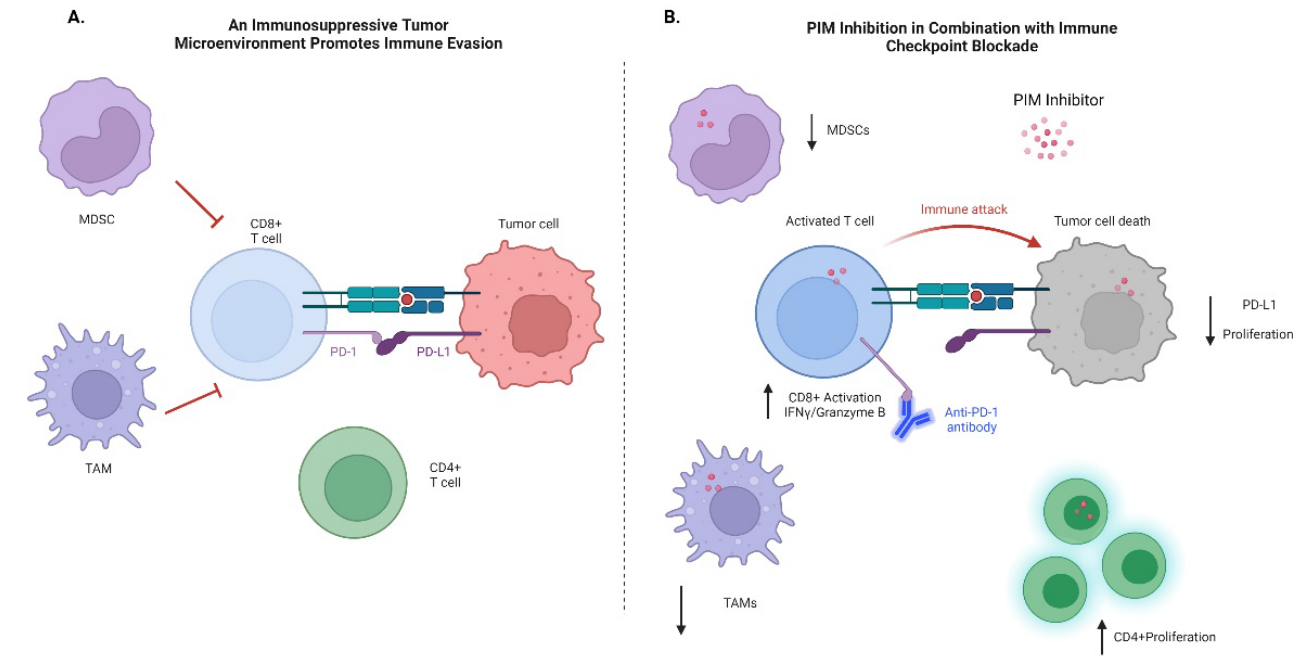
Figure 1. Targeting PIM kinases in combination with immune checkpoint therapy. ( A ) The tumor microenvironment contains immunosuppressive immune cells, including myeloid-derived sup- pressor cells (MDSCs) and tumor-associated macrophages (TAMs), that prevent anti-tumor responses. Tumor cells, MDSCs, and TAMs express programmed death ligand 1 (PD-L1), an immune checkpoint molecule that dampens cytotoxic CD8 + T-cell immune responses. ( B ) PIM inhibitors used in combination with immune checkpoint inhibitors decrease MDSCs and TAMs, increase CD4 + T cell proliferation, and increase CD8 + T cell activation, thereby promoting decreased tumor growth. Adapted from “Immune Checkpoint Inhibitor Against Tumor Cell”, by BioRender.com (2022). Re- trieved from https://app.biorender.com/biorender-templates (accessed on 29 August 2022).